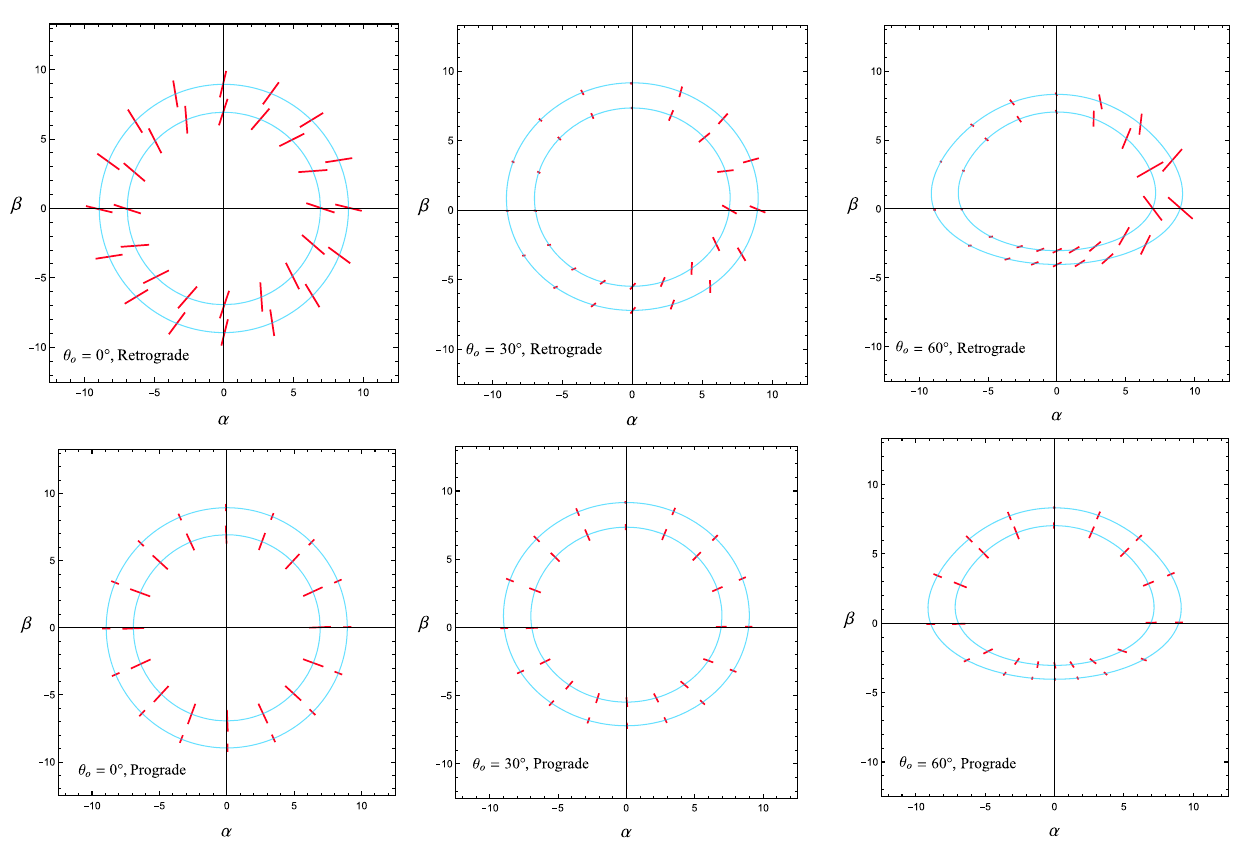
Fig. 3 Primary images of sources and their polarizations at B = 0 .